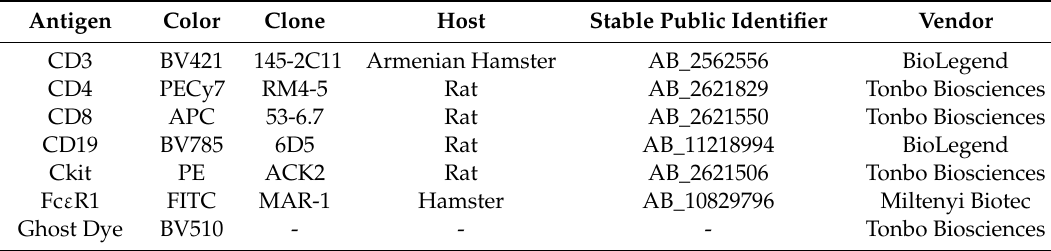
Table 1. Fluorochrome conjugated monoclonal antibody panel for flow cytometry of hapten treated draining LN samples used to identify distinct cell